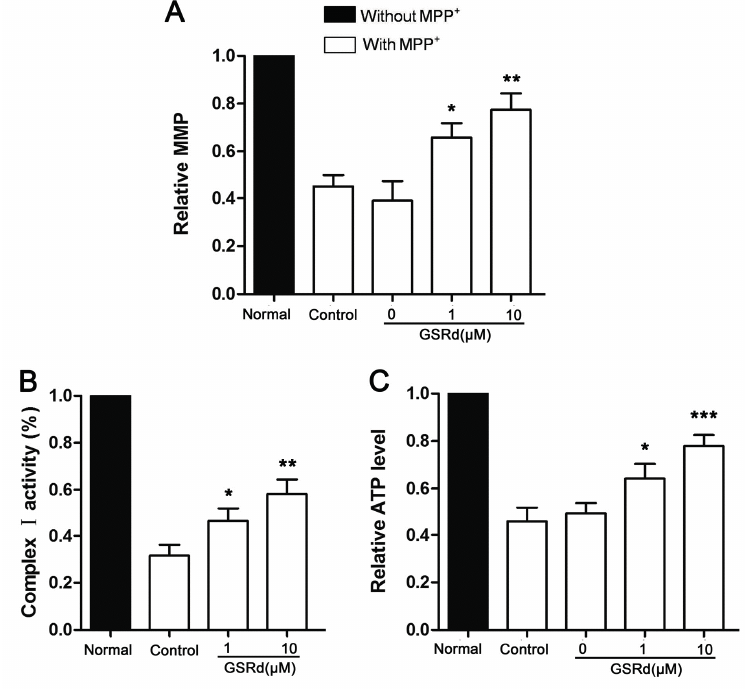
Figure 3. Effects of ginsenoside Rd on mitochondrial function in 1-methyl-4- phenylpyridinium (MPP + ) treated SH-SY5Y cells. ( A ) Relative changes of mitochondrial membrane potential (MMP); ( B ) relative activity of mitochondrial respiratory complex I; and ( C ) relative intracellular ATP levels. * p < 0.05; ** p < 0.01; and *** p < 0.001 vs. control